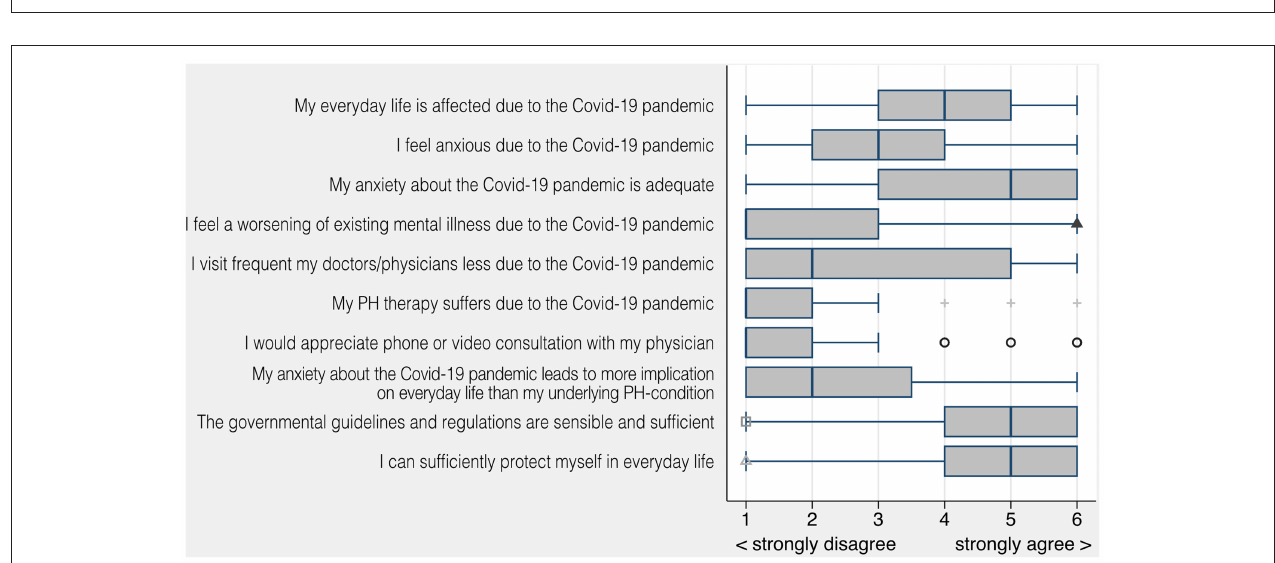
FIGURE 1 | Changes in HADS-A and HADS-D categories prior to and during the Covid-19 pandemic.